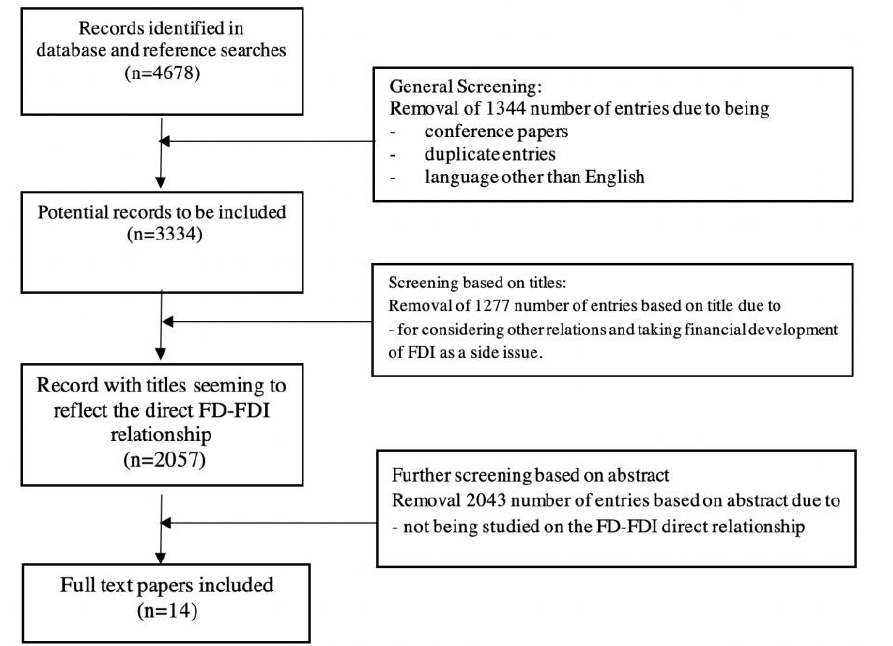
Figure 1: Procedure of inclusion of papers for final